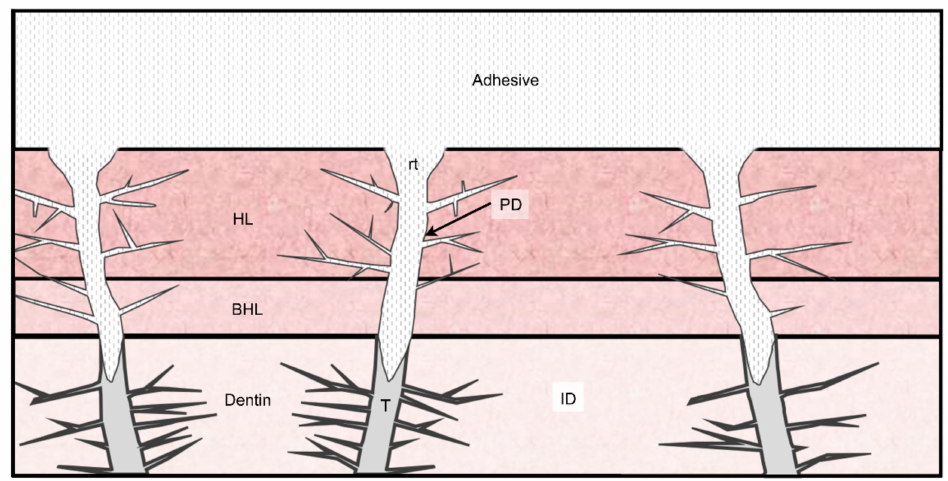
Figure 1. Resin-dentin interface schematic illustration. ID, intertubular dentin; PD, peritubular dentin; t, dentinal tube; rt, resin tag; HL, hybrid layer; and BHL, bottom of the hybrid